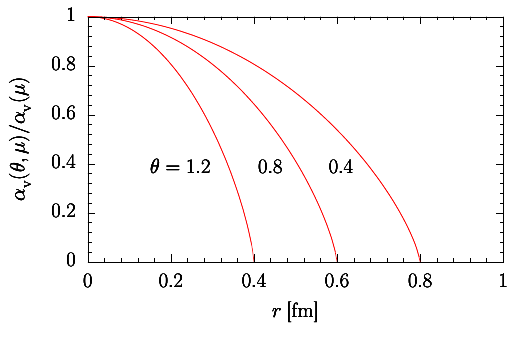
Figure 9. The running coupling α V p θ,µ q divided by the ensemble average α V p µ q ” α V p 0 ,µ q as a function of distance for several values of θ .